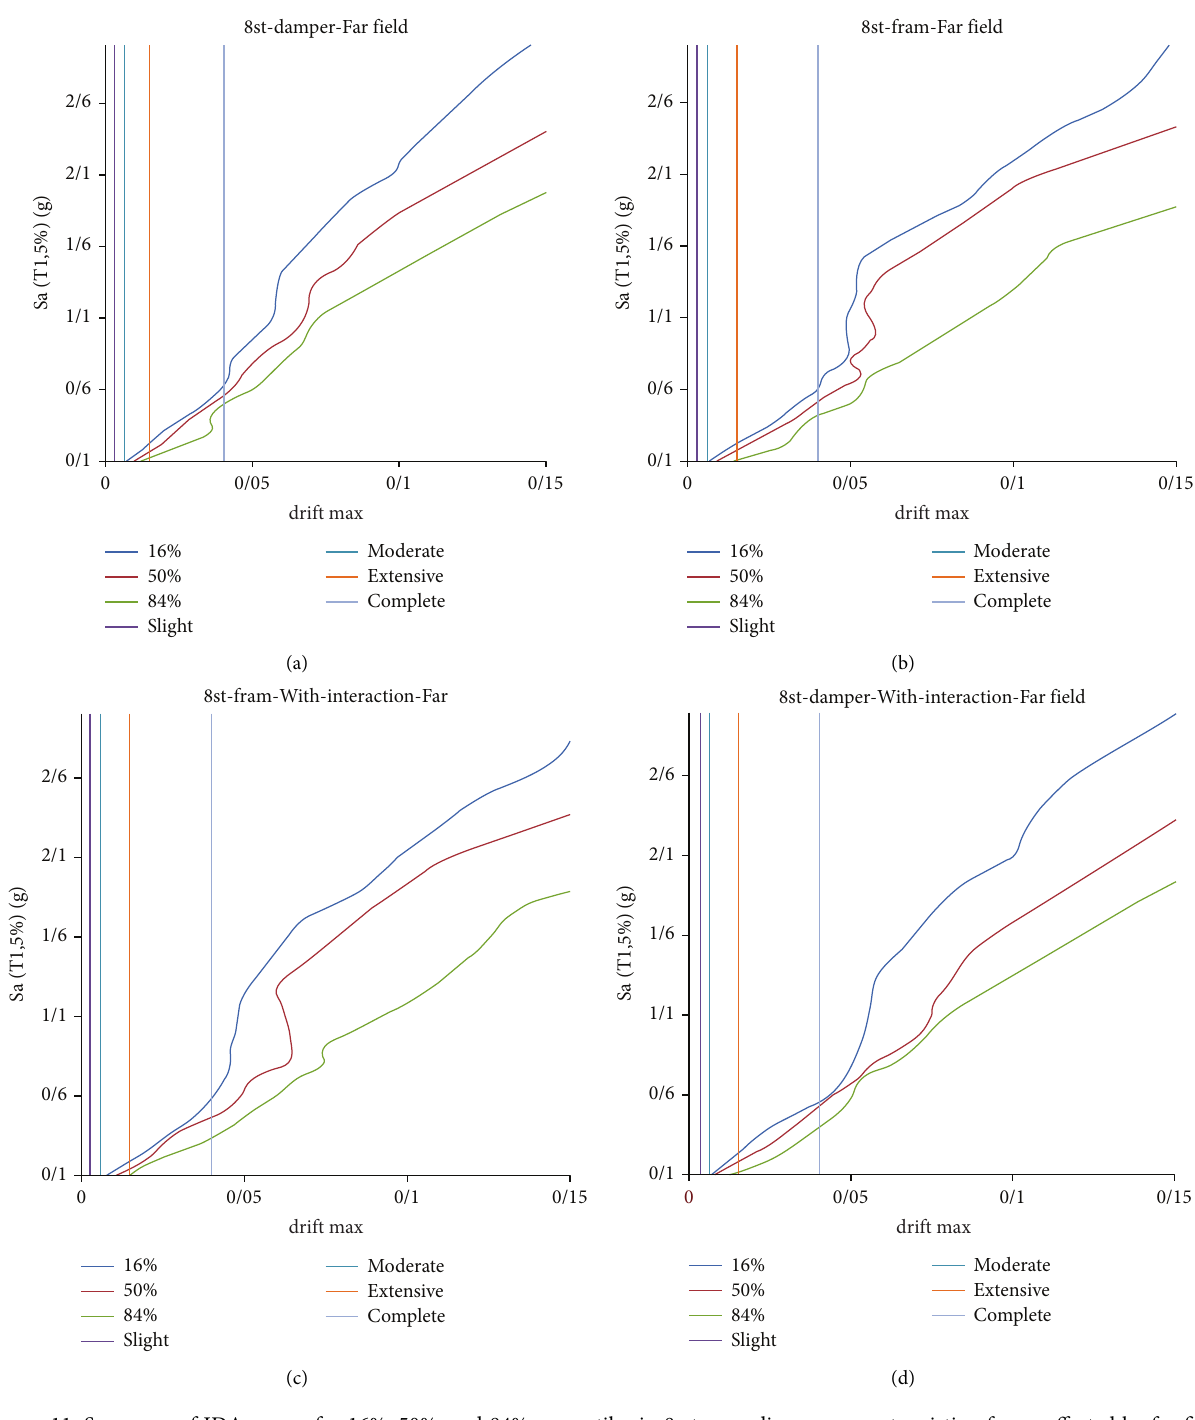
Figure 11: Summary of IDA curves for 16%, 50%, and 84% percentiles in 8-story ordinary moment resisting frame affected by far-field earthquakes. Examined cases: (a) with damper without considering SSI; (b) without damper and SSI effect; (c) with damper and considering SSI; (d) without damper but considering SSI